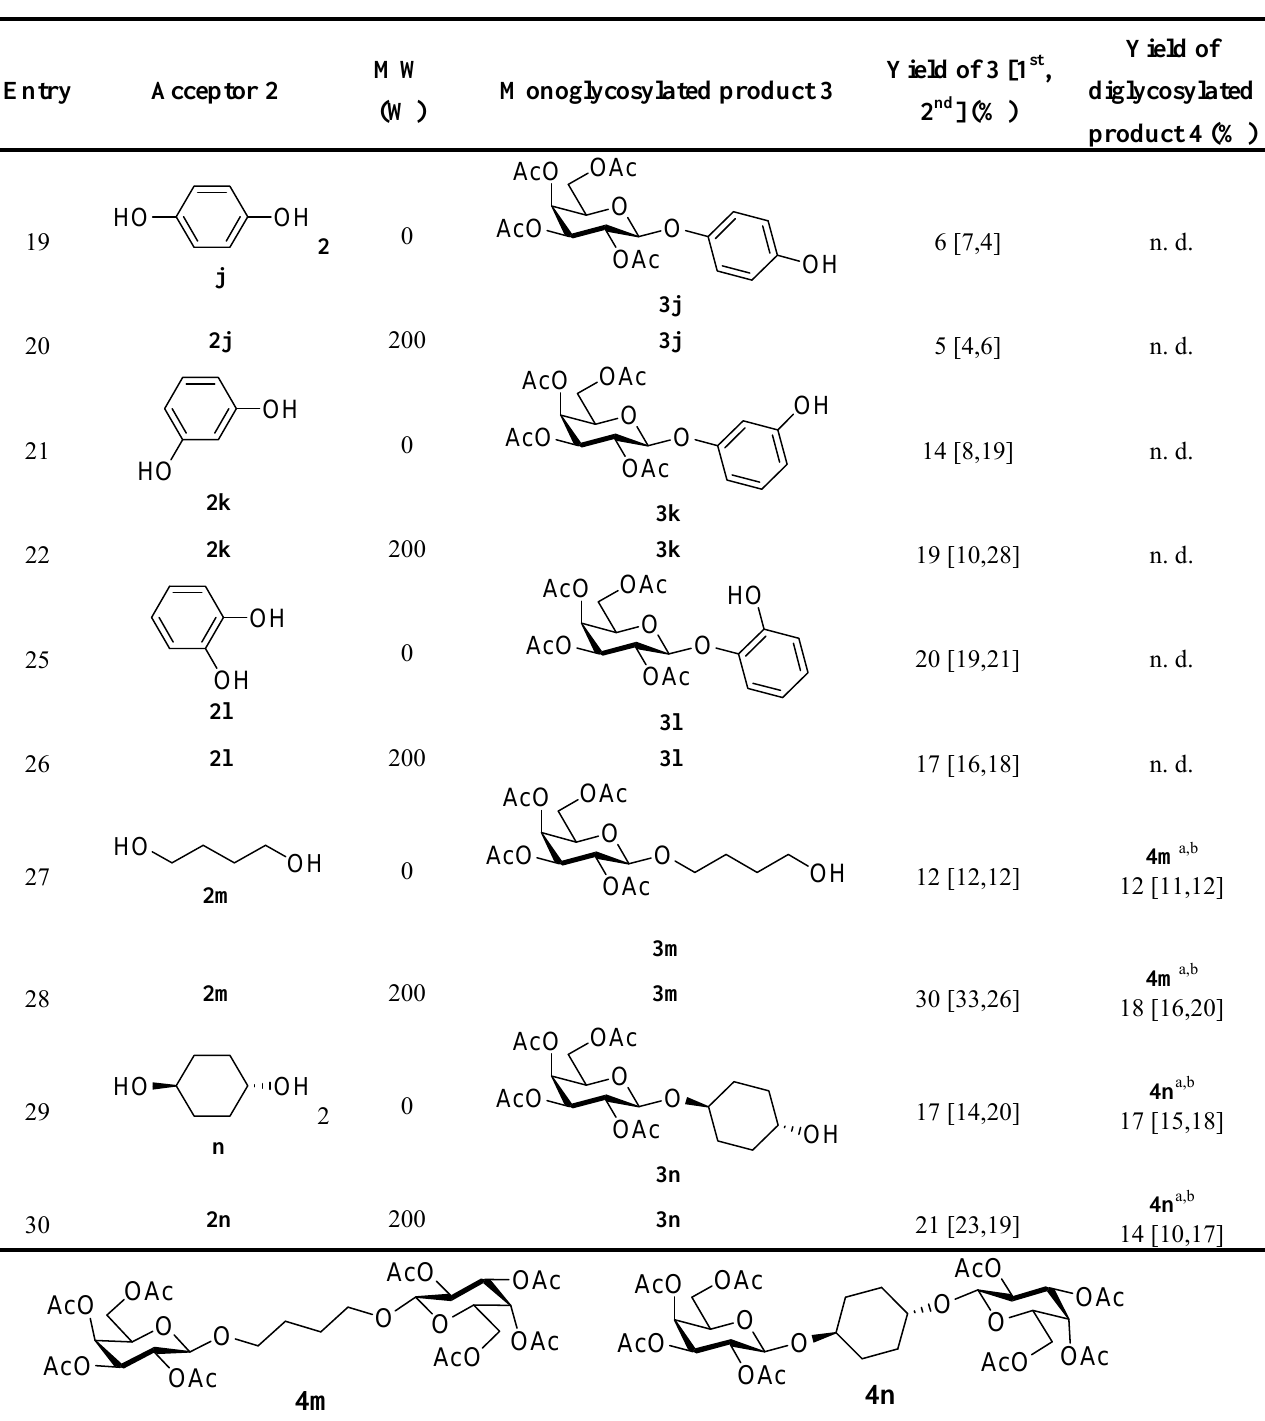
Table 3. Glycosylation of 1 and diol-type glycosyl acceptors 2j - n promoted by ZrO in scCO with or without MW irradiation. 2